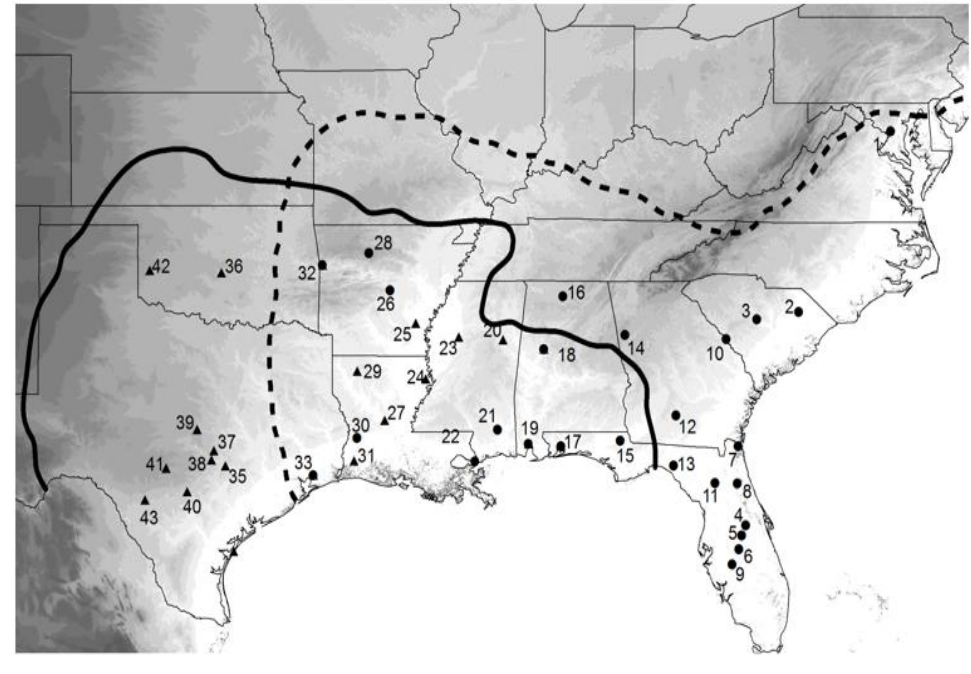
Figure 6. Map of the south-eastern United States of America showing collection localities for 177 G. rubens and 188 G. texensis sampled for mitochondrial DNA genetic variation. Figure modified from Gray et al .